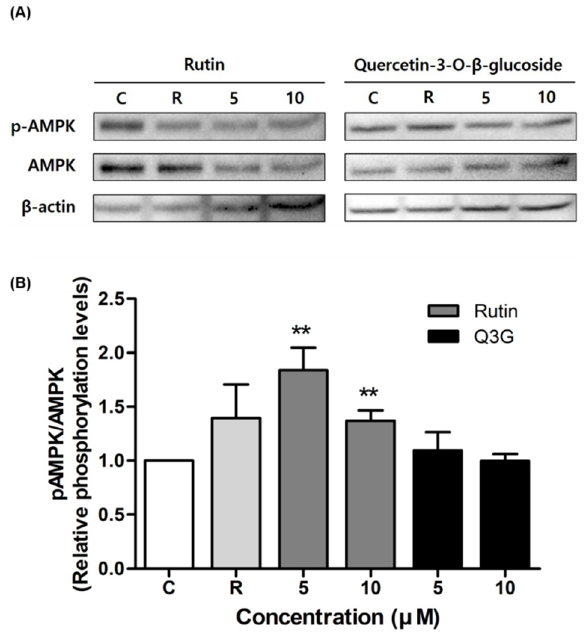
Figure 5. Effect of rutin and quercetin-3- O - β - D -glucoside (Q3G) on AMP-activated protein kinase (AMPK) phosphorylation in insulin-stimulated 3T3-L1 adipocytes. ( A ) Representative Western blots for AMPK and phospho-AMPK. ( B ) Quantification of relative phosphorylation levels of AMPK. Phospho-AMPK level was normalized to total AMPK for each compound. Data are means ± standard error of the mean (SEM, n = 3); ** p < 0.01 versus control. C, control. R, rosiglitazone 10 μ M.